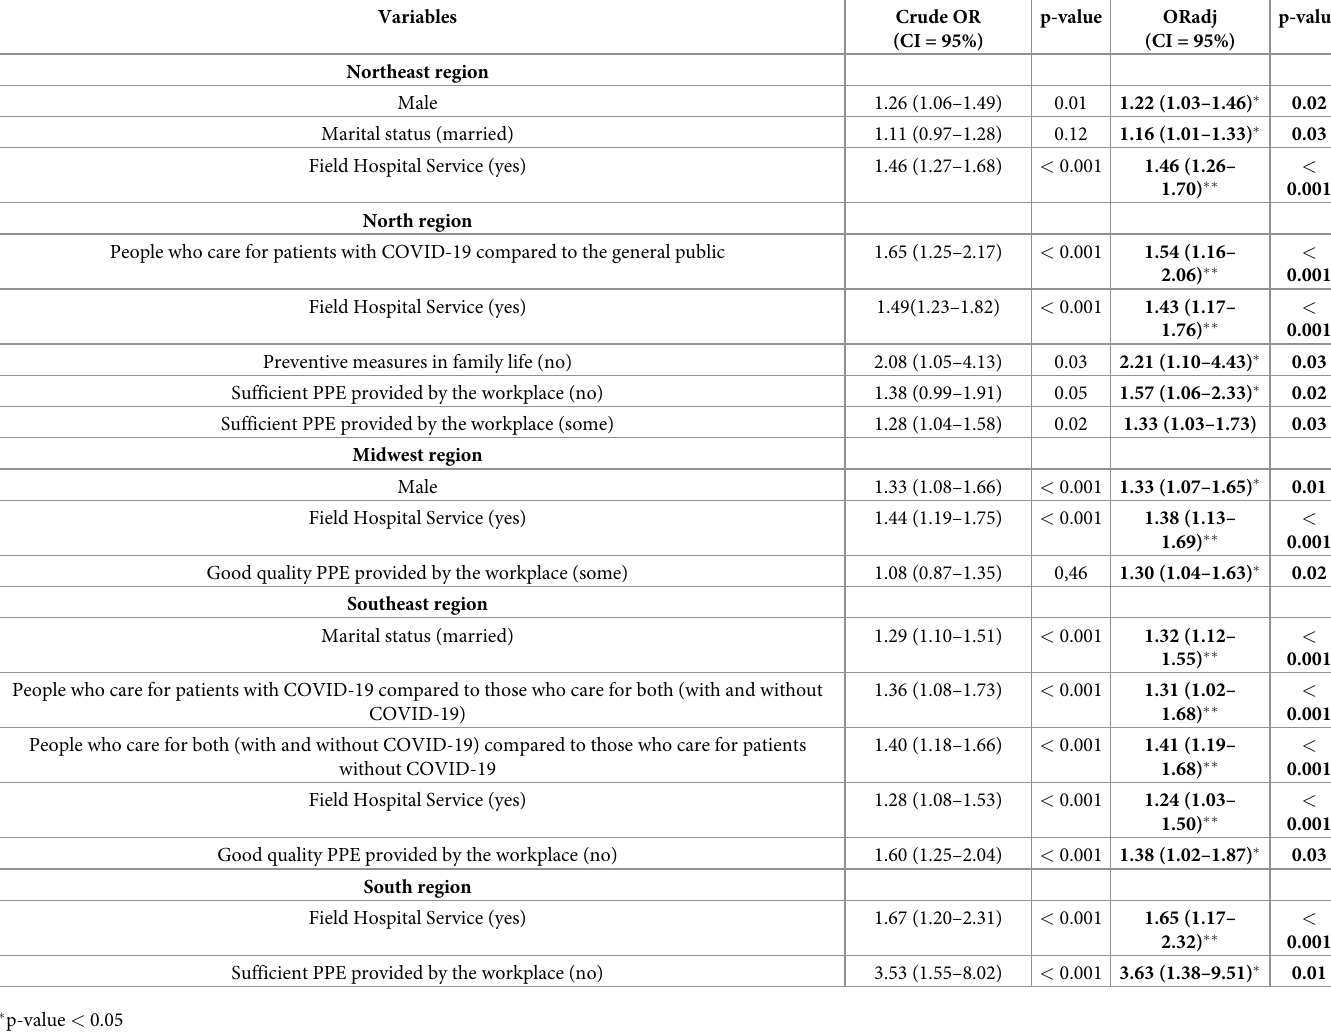
Table 4. Odds ratios by logistic regression for the diagnosis of COVID-19 according to regions of Brazil,